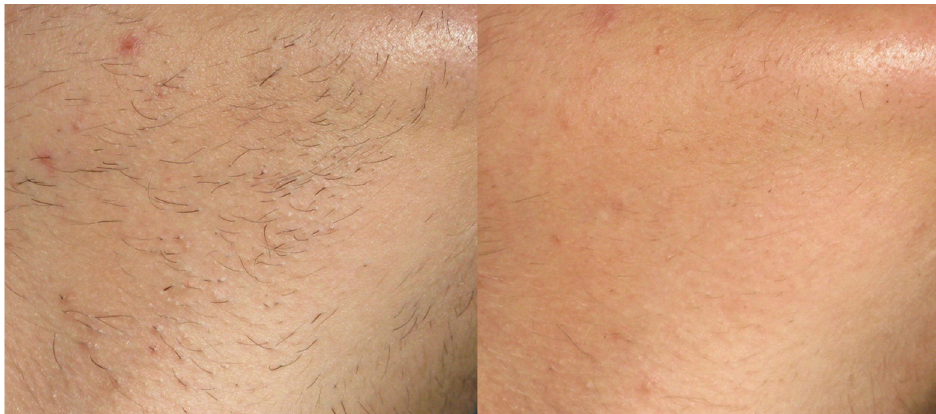
Figure 2. Patient 1 left side treated with traditional technique.